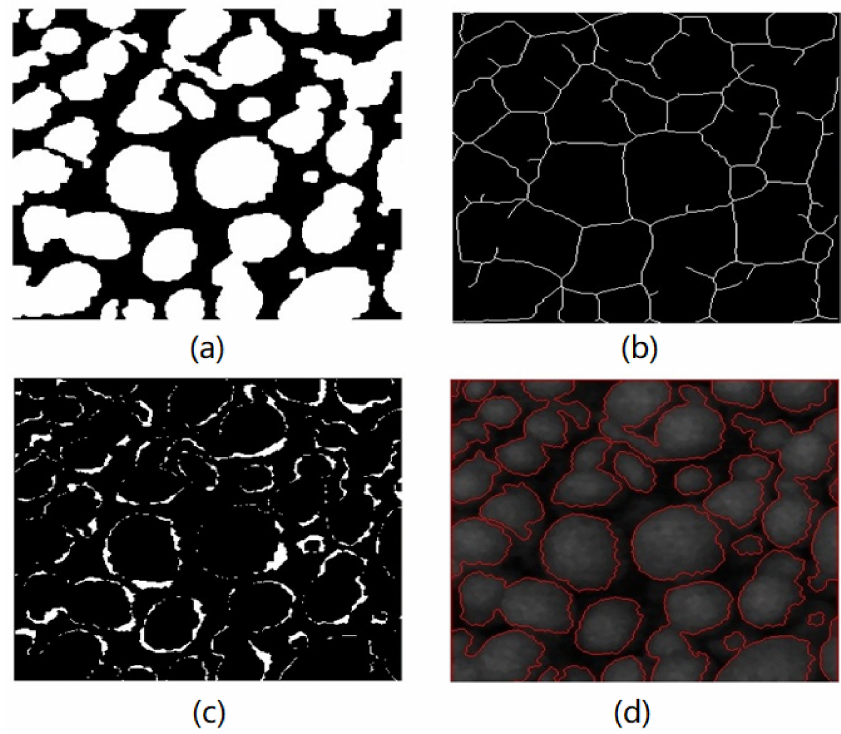
Figure 4. Watershed segmentation of the foreground area. ( a ) Defined foreground area. ( b ) The skeleton of the background area. ( c ) Missing foreground areas. ( d ) Final segmentation